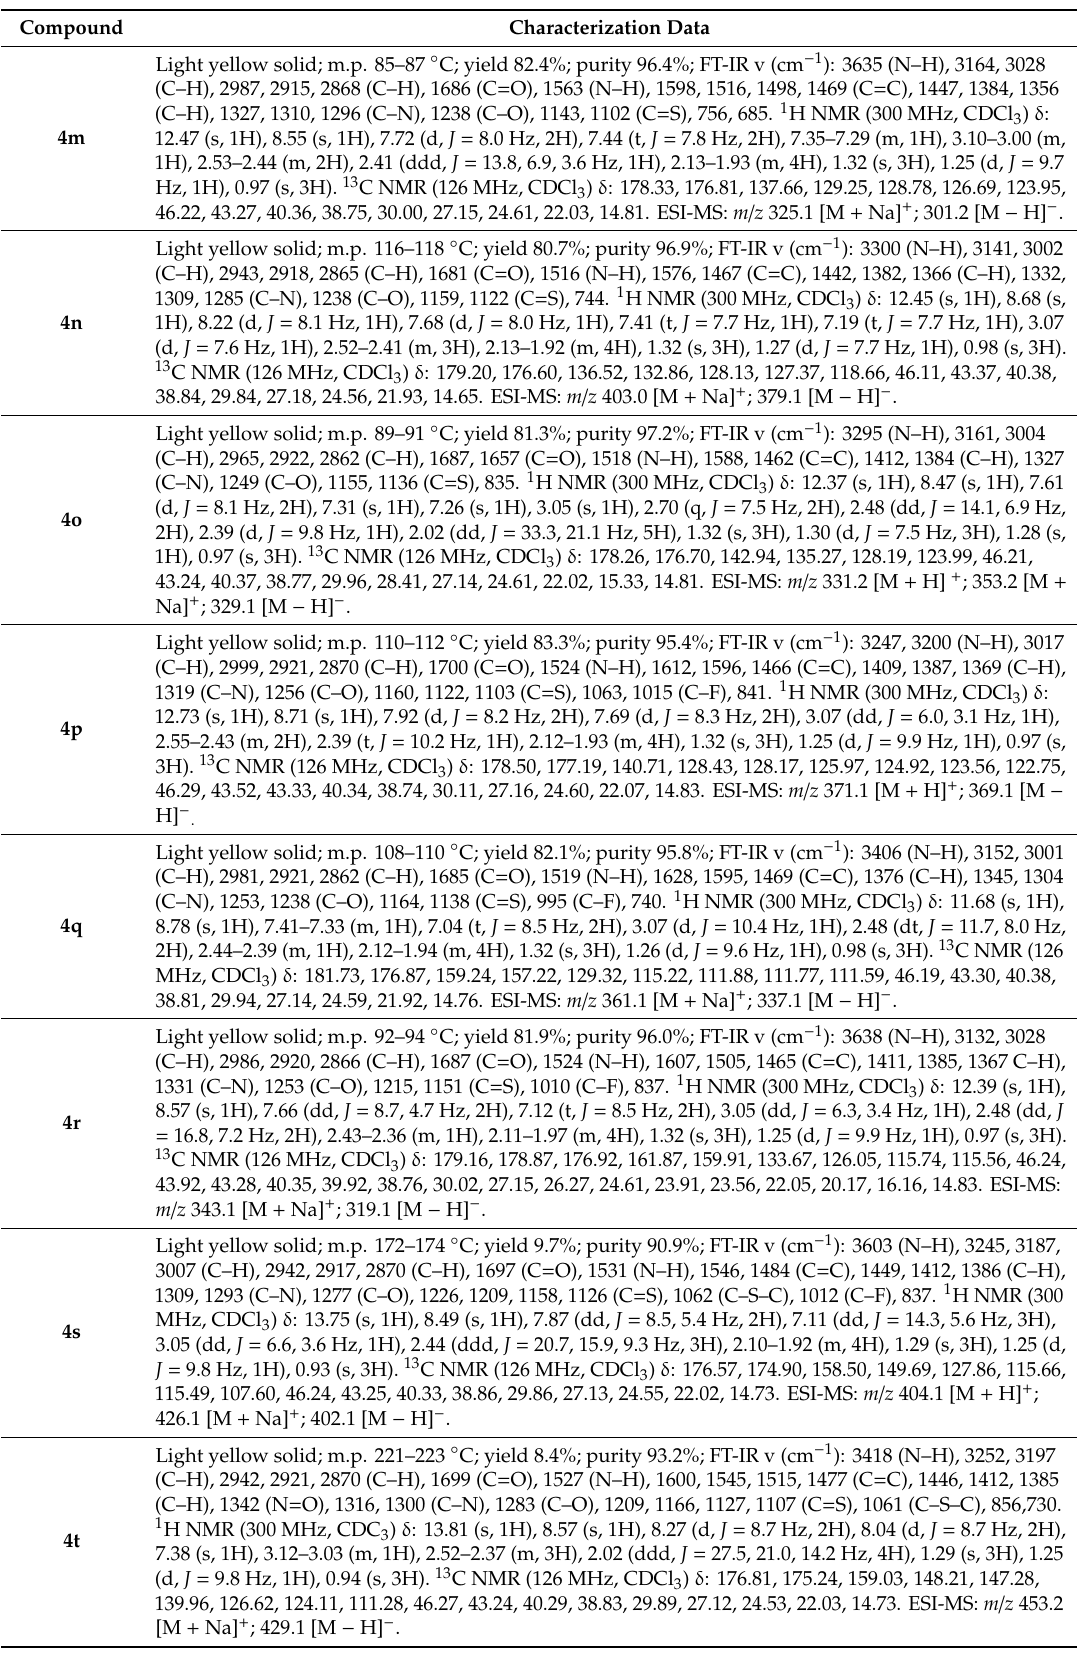
Table 5. Characterization data of N -aryl- N ’-myrtanyl acylthiourea and N -(4-arylthiazol-2-yl)- N